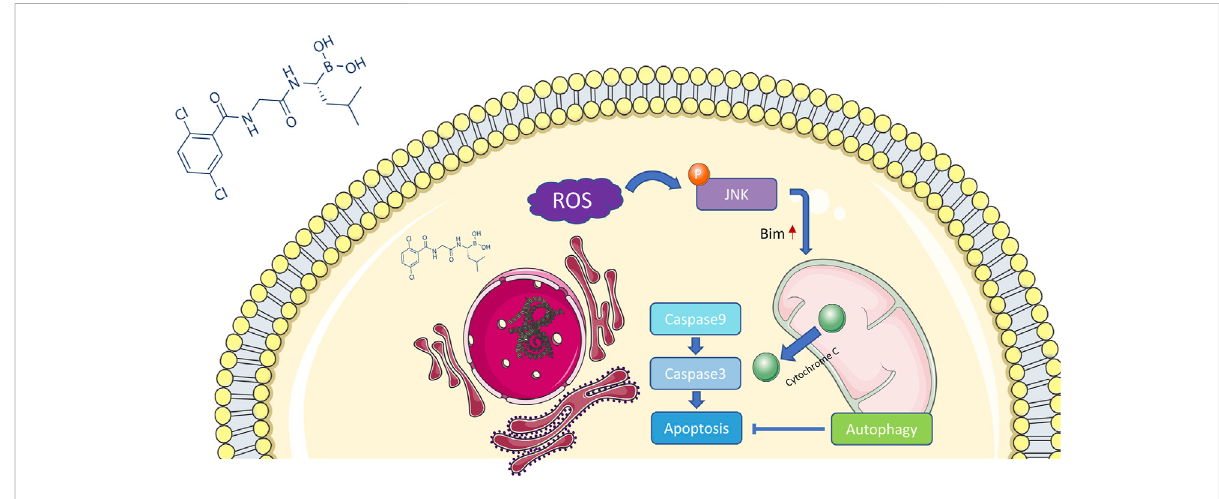
FIGURE 9 Potential mechanism of MLN2238 inducing apoptosis in